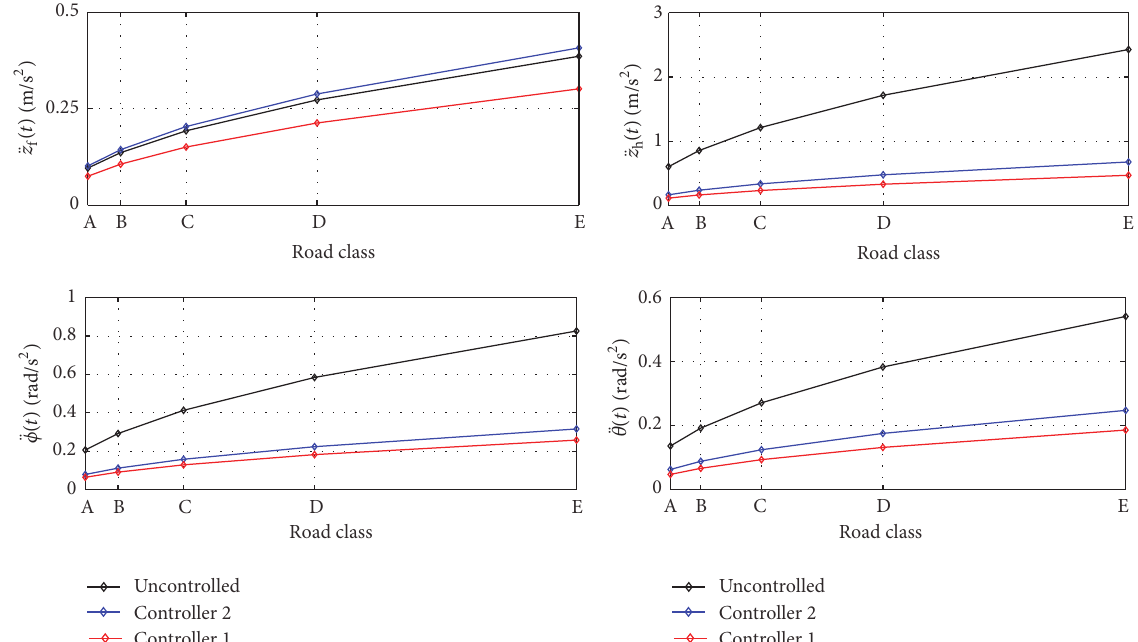
Figure 7: Peak values of acceleration responses under A grade, B grade C grade, D grade, and E grade road class disturbance inputs.